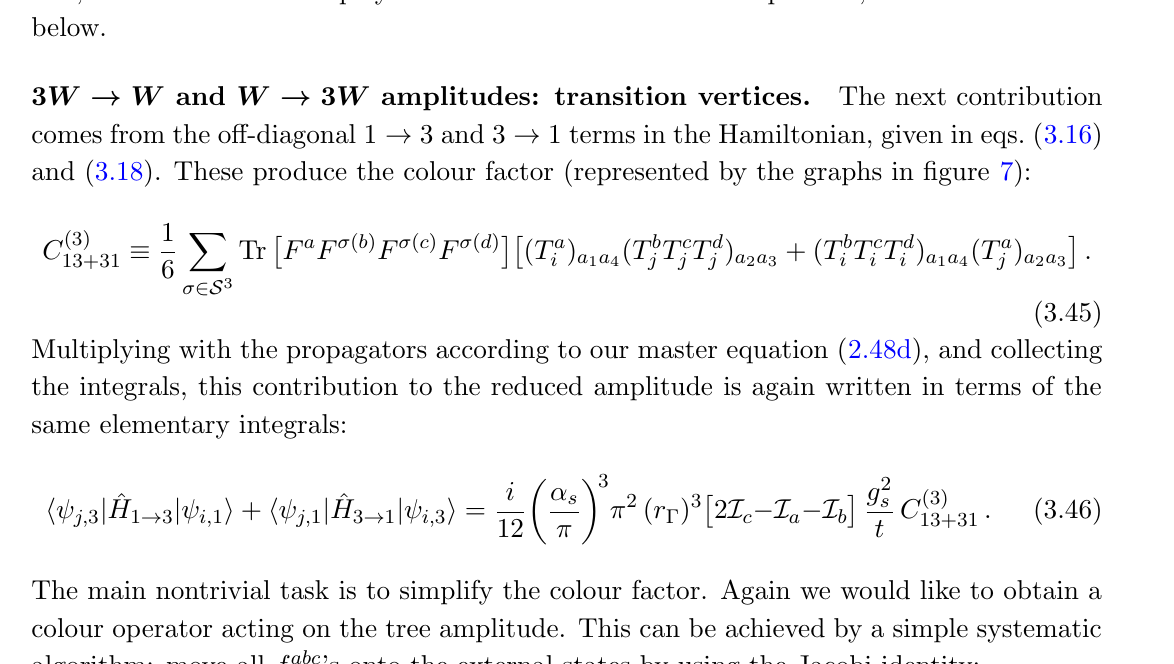
Figure 7 . Diagrams representing the colour structure of the 1 that these diagrams are di(cid:11)erent from the ones representing the kinematical structure of the 1 and 3 1 transitions, i.e. H 13 ( p 1 ; p 2 ; p 3 ) in eq. (3.17). This is a consequence of the fact that the ! BFKL evolution derived in section 3.1 represents an e(cid:11)ective (cid:12)eld theory in 2 which the longitudinal degrees of freedom have been integrated